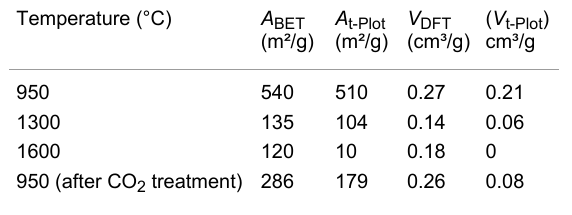
With the observed capillary condensation at high relative pres- sure, the adsorption isotherm of carbon tubes ( 4 ) (Figure 6a)